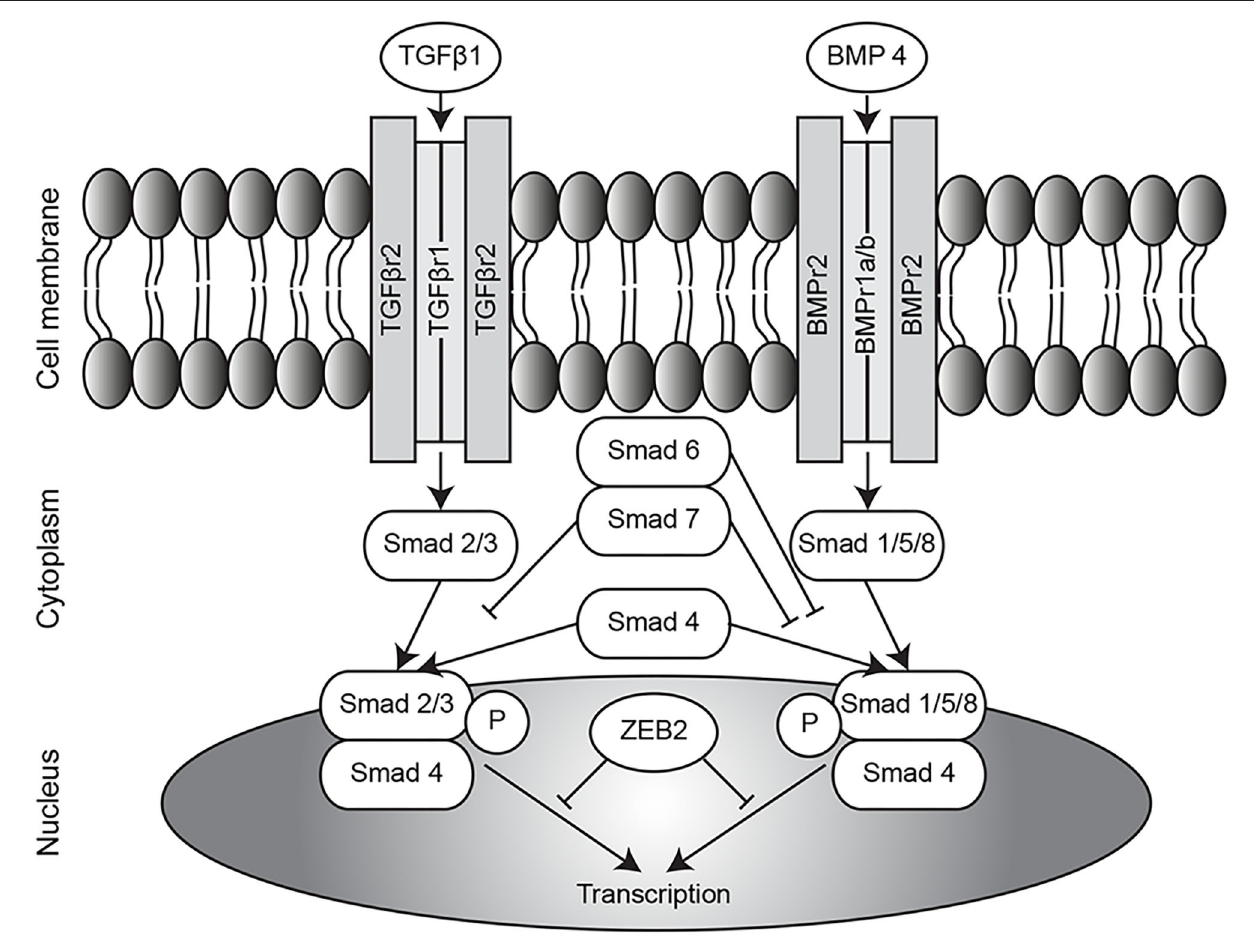
FIGURE 1 | Overview of TGF β /BMP pathway. Overview of the TGF β and BMP pathways. TGF β , transforming growth factor β ; BMP, bone morphogenetic protein; ZEB2, zinc finger E-box binding homeobox 2; P,